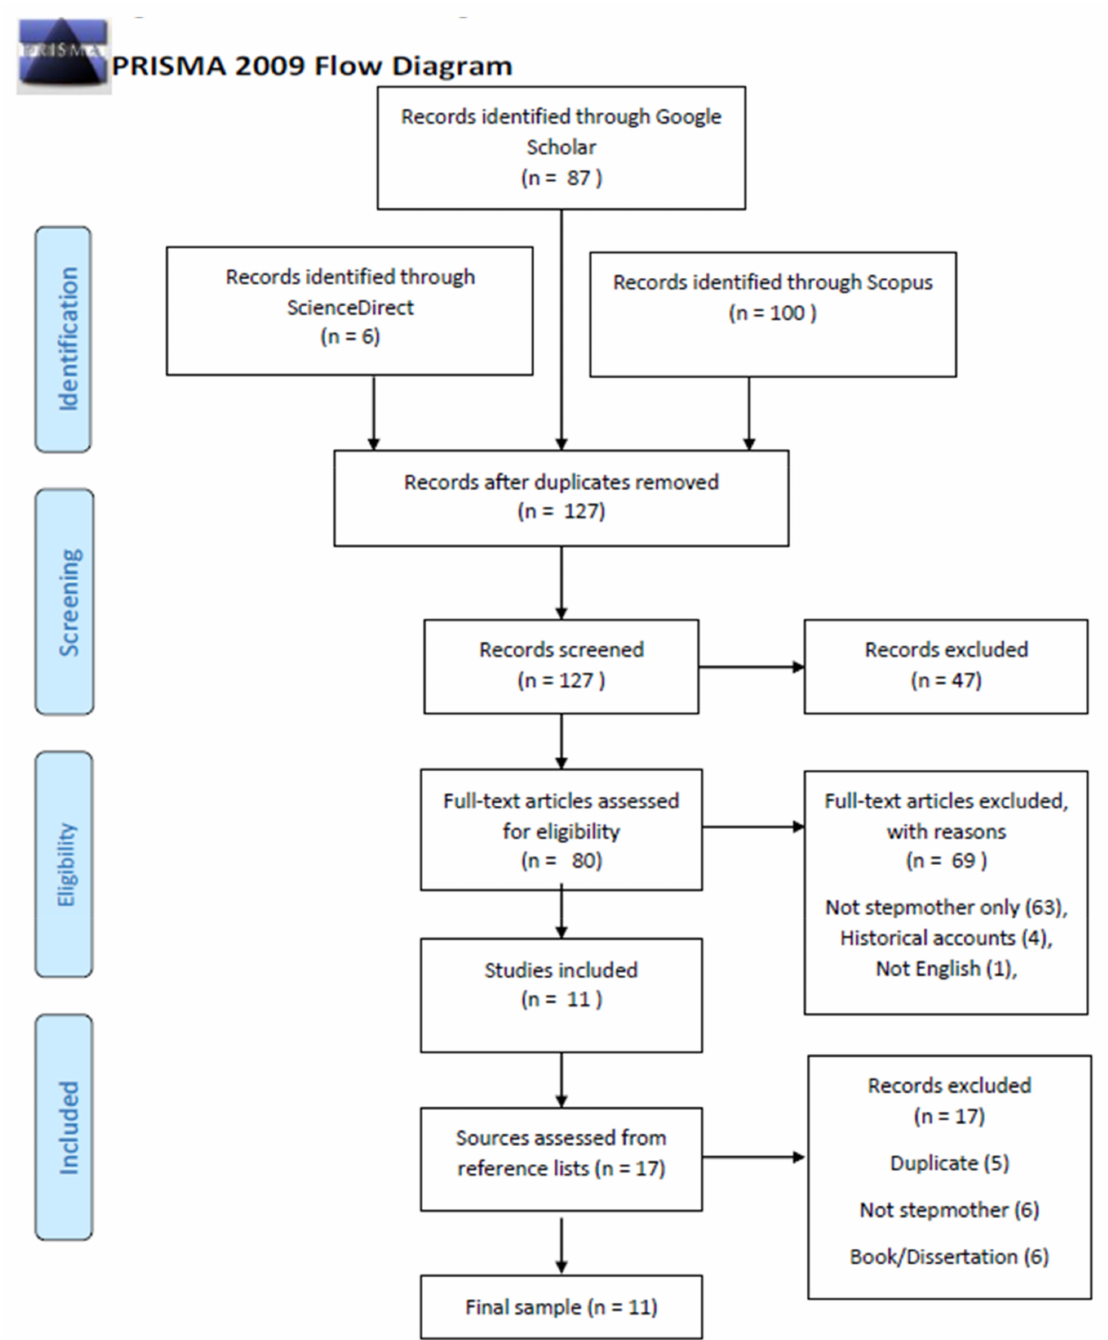
Figure 1. Prisma 2009 Flow